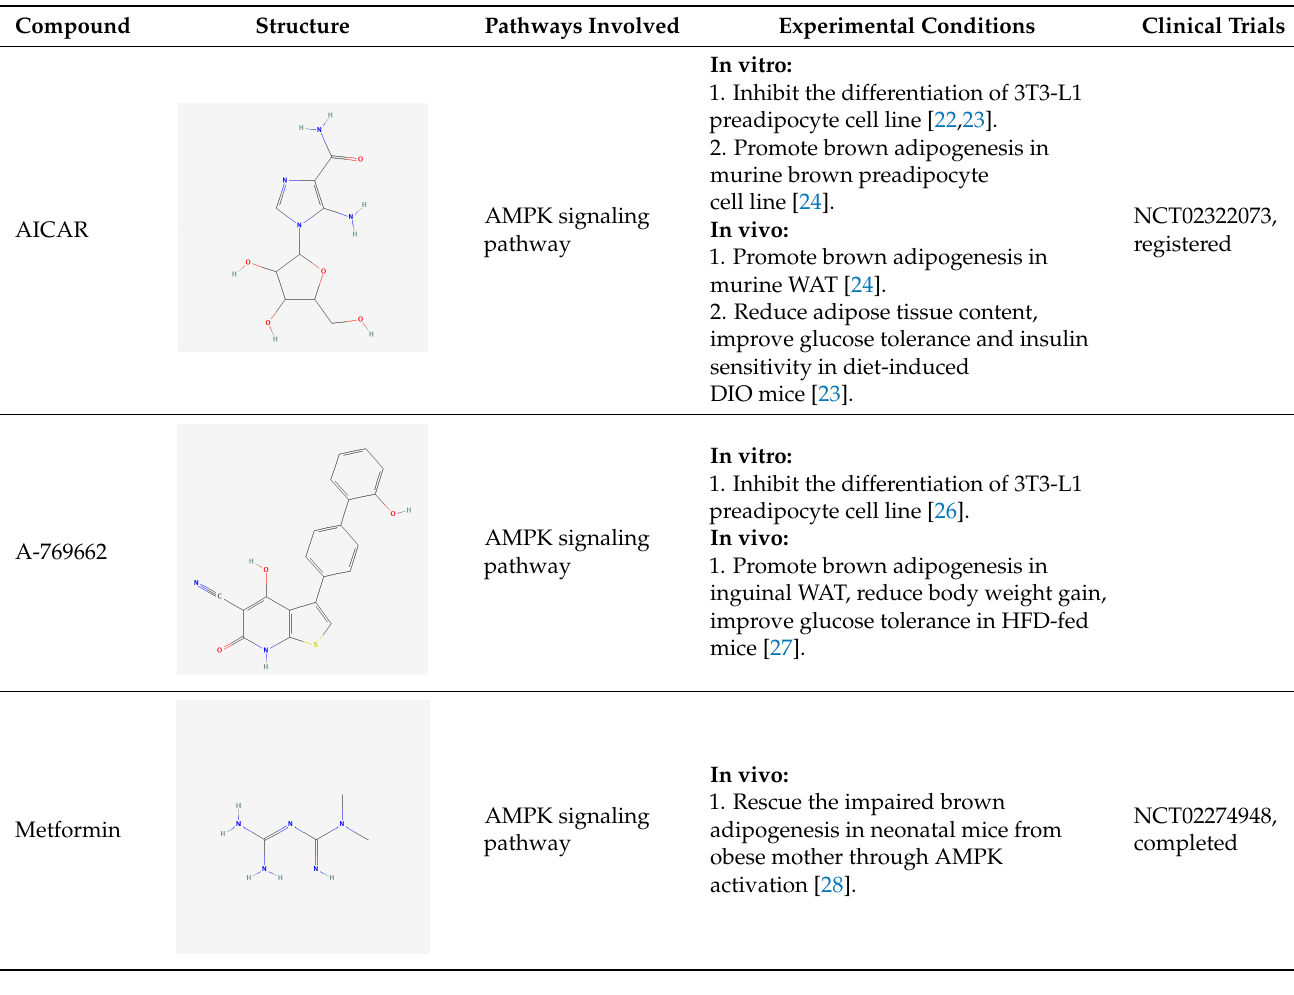
Table 1. Structure, pathway involved, experimental conditions and obesity-related clinical trials of compounds targeting signaling pathways with adipogenesis modulating